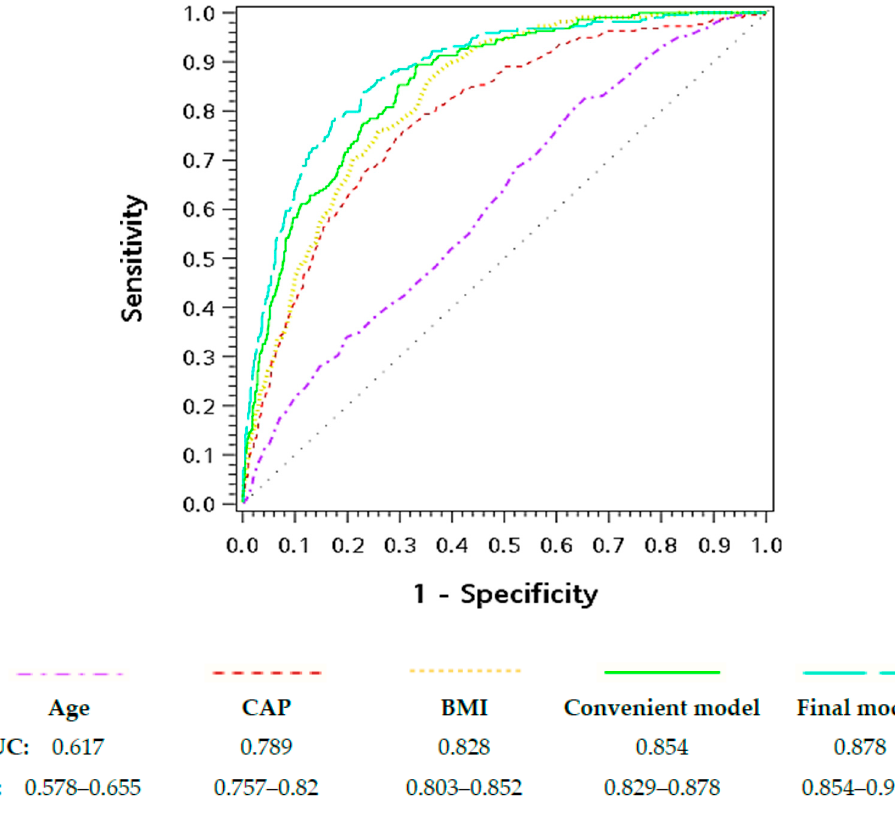
Figure 1. Receiver operating characteristic curves for predicting the presence of metabolic syndrome. Note: The AUC results not shown for the clarity of illustrating were hemoglobin A1c: 0.736 (CI, 0.698–0.775), GPT: 0.709 (CI, 0.672–0.746), and GFR: 0.64 (CI, 0.601–0.679).